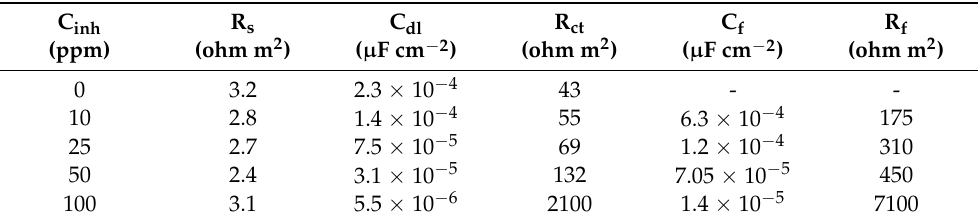
Table 5. Electrochemical parameters to fit the EIS data of X-120 steel corroded in a CO 2 -saturated 3% NaCl solution containing different concentrations of gemini